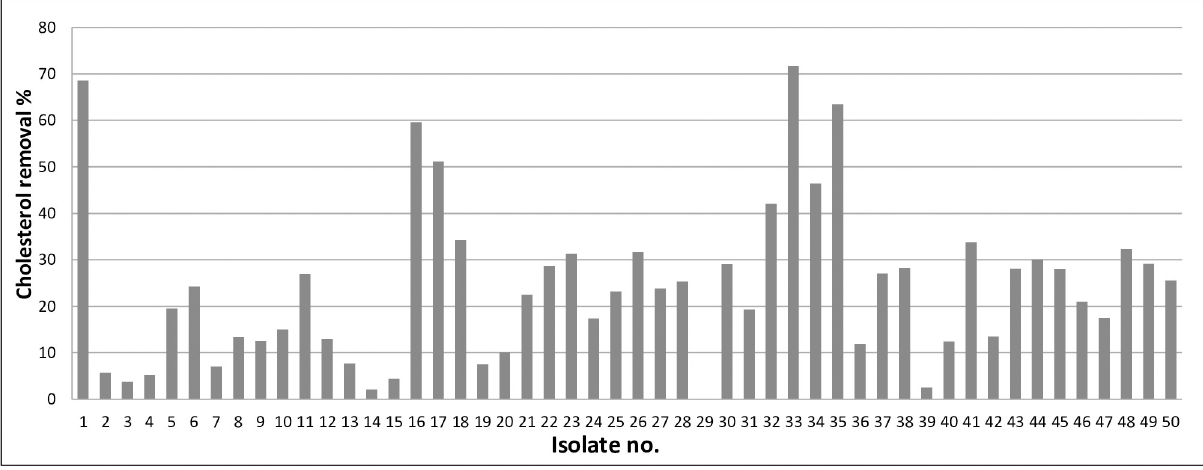
Fig 1. Preliminary screening of LAB isolates for their cholesterol removal capability.